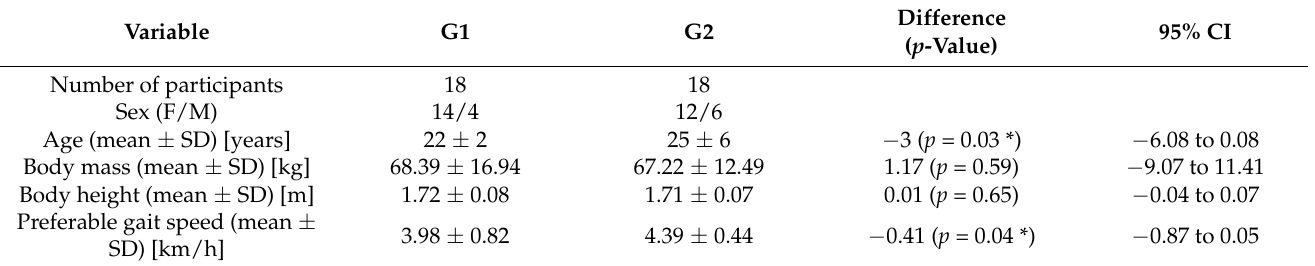
Table 1. The characteristics of the examined